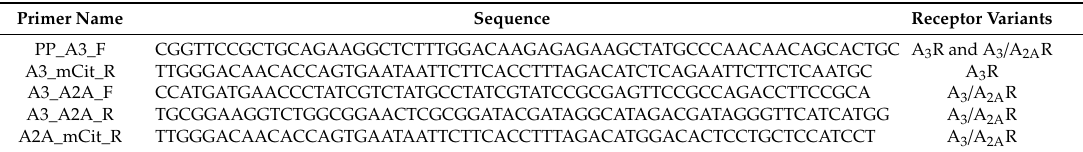
Table 2. List of primers used in this